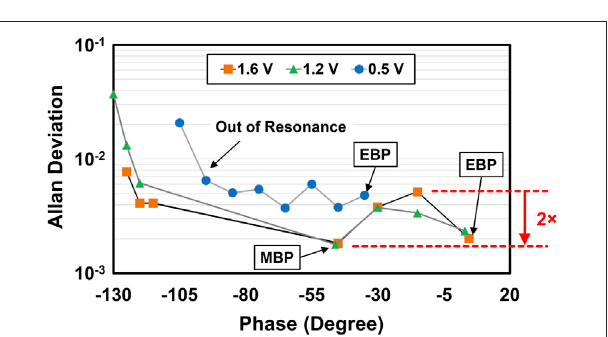
FIGURE9| MeasuredAllendeviationofanoxidevibro-impactresonator alongthetappingregion.ReproducedfromTsaietal.(2020b)withpermission from